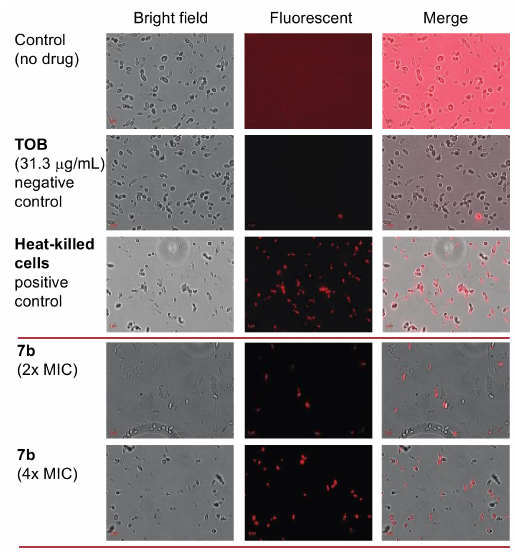
Figure 4. The representative dose-dependent membrane permeabilization effects of TOB and its derivative 7b on C. albicans ATCC 10231 (strain A ). From top to bottom: propidium iodine (PI) dye uptake by yeast cells without drug, with TOB (31.3 µ g/mL), killed by heat, with 7b (2 × MIC), and with 7b (4 ×